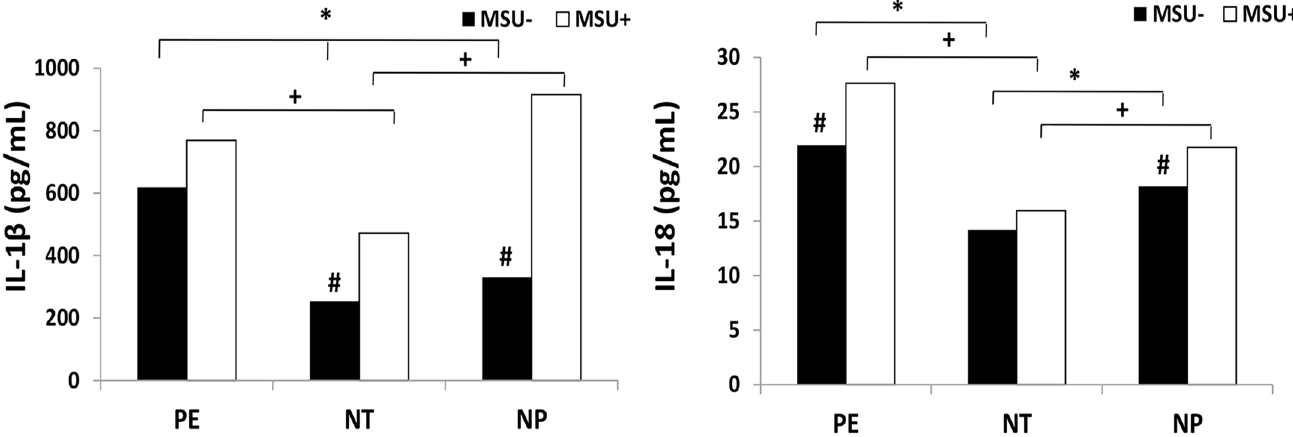
Fig 5. TNF- α production by monocytes. Monocytes from pregnant women with preeclampsia (PE), normotensive pregnant women (NT) and non-pregnant women (NP), were cultured in the presence (MSU + ) or absence (MSU - ) of monosodium urate. Results are shown as median. * P < 0 . 05 shows significant difference between MSU - groups; + P < 0 . 05 shows significant difference between MSU + groups; # P < 0 . 05 vs MSU +